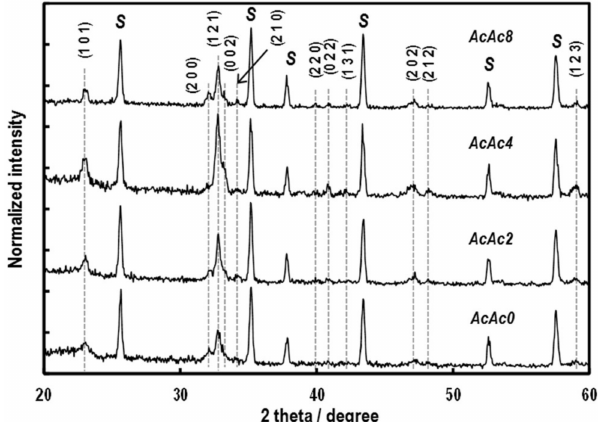
Figure 5. XRD patterns of the SmFeO 3 thin-films prepared from AcAc0, 2, 4 and 8 precursors at 750 ◦ C.